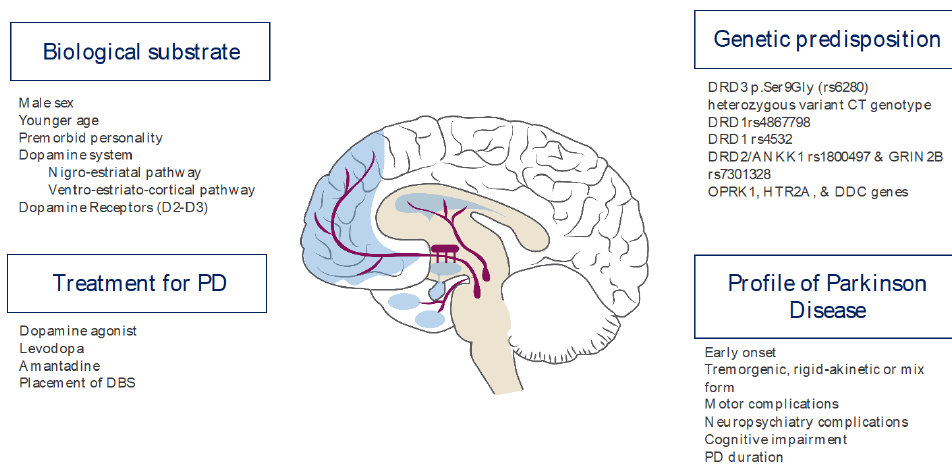
Figure 1. Risk factors for ICDs in patients with PD.